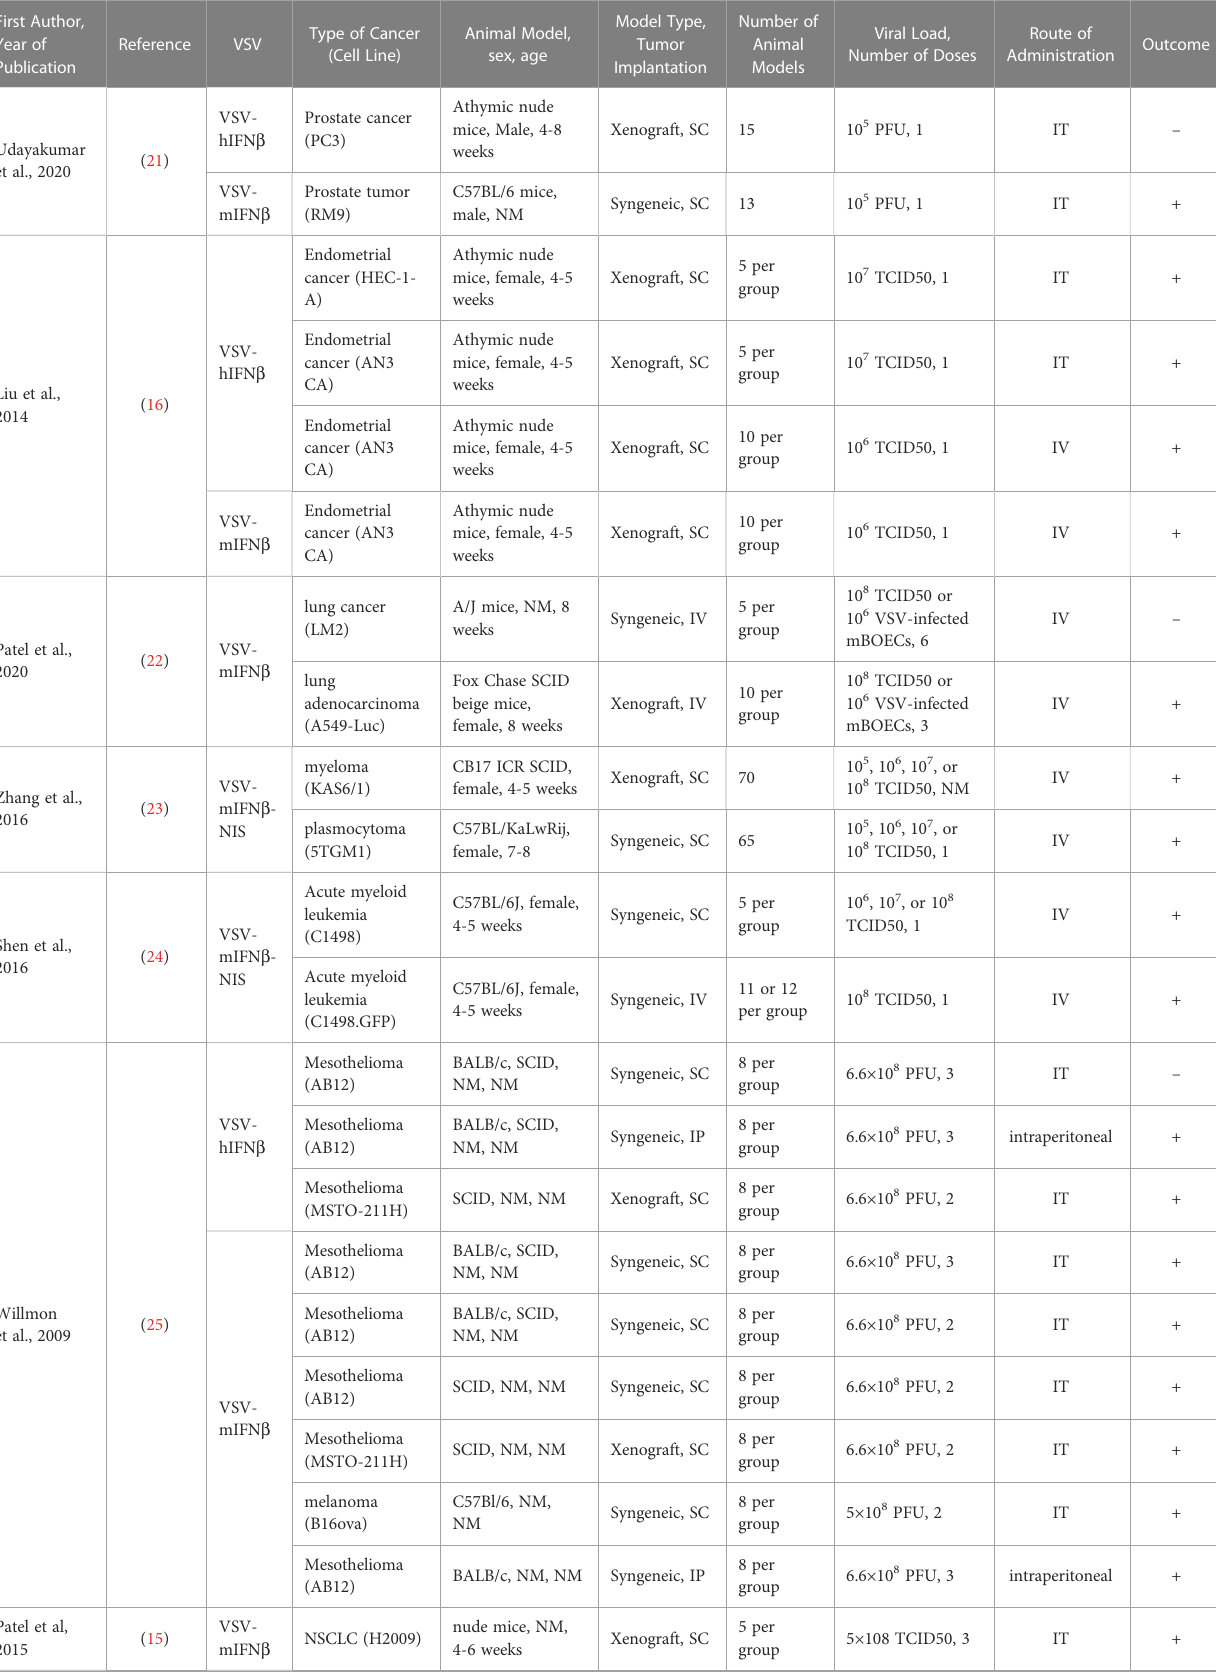
TABLE 1 Summary of the experimental details of the reviewed